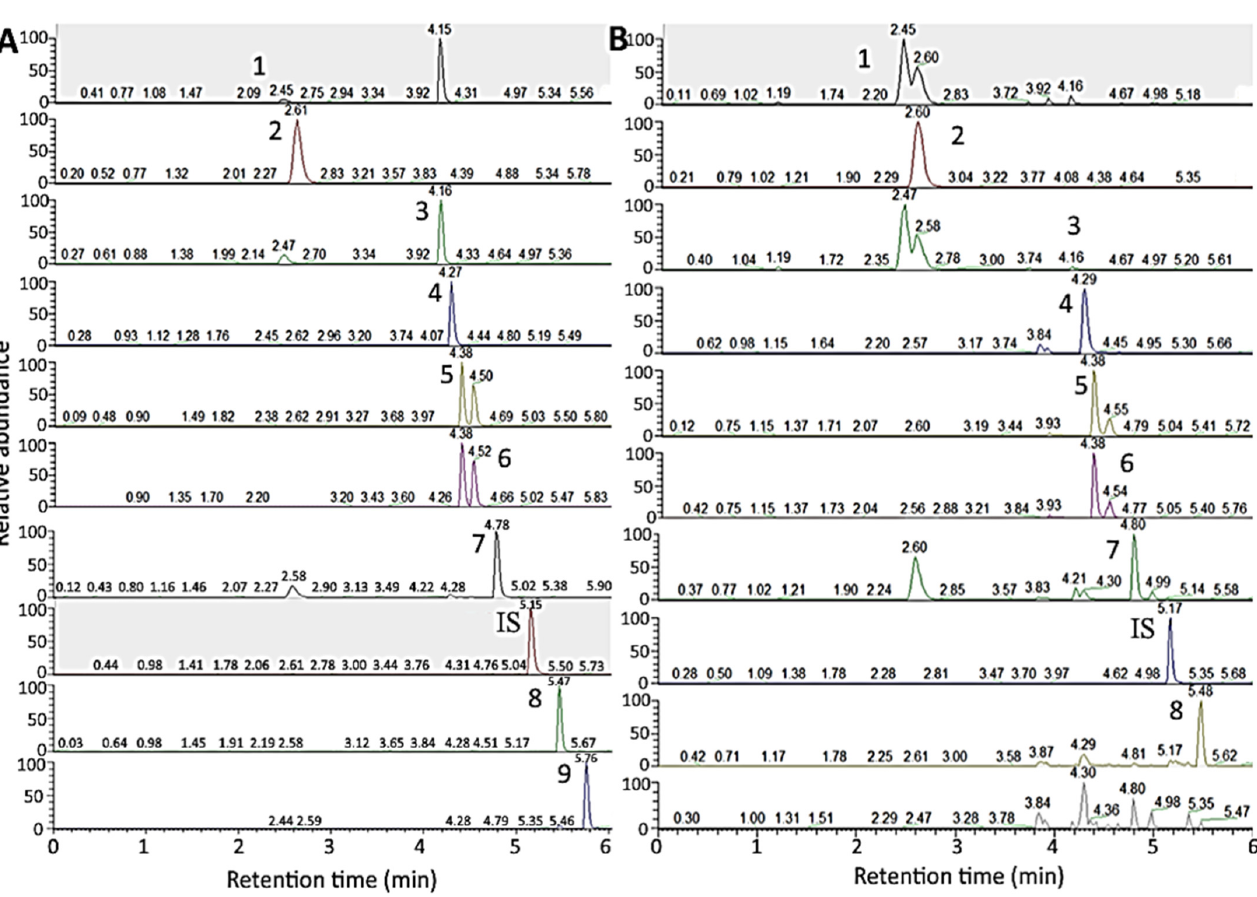
Figure 5. UPLC-HRMS-MS/MS chromatograms for separation and detection of ginsenosides in standards mixture ( A ) and American ginseng root residue sample ( B ) by SRM mode. Separation conditions: column type, Acquity UPLC BEH C18 column; column dimension, 50 × 2.1 mm ID and particle size 1.7 µ m; mobile phase, 0.5 mM ammonium acetate and acetonitrile; flow rate, 0.4 mL/min; column temperature, 50 ◦ C; detection mode, selected reaction monitoring (SRM) mode. Peaks: 1,